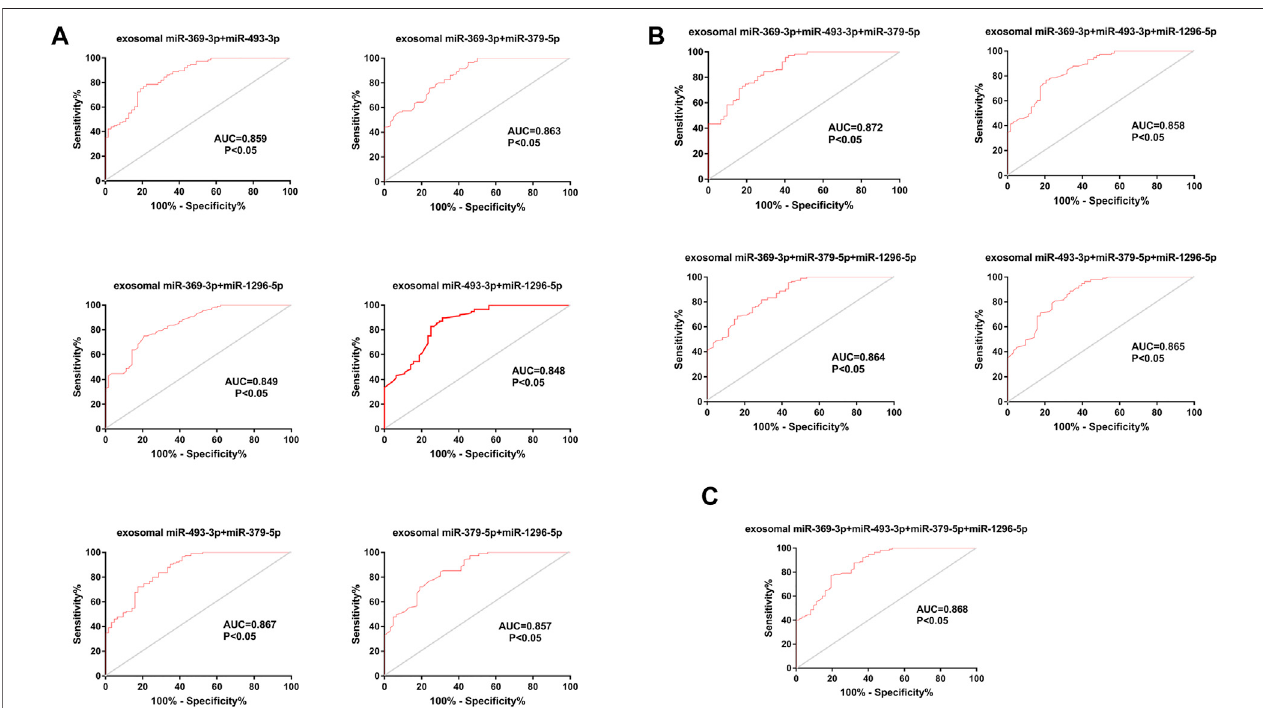
FIGURE 7 | ROC curve analysis of composite biomarkers. (A) . Different combinations of two miRNAs. (B) . Different combinations of three miRNAs. (C) A combination of four miRNAs.